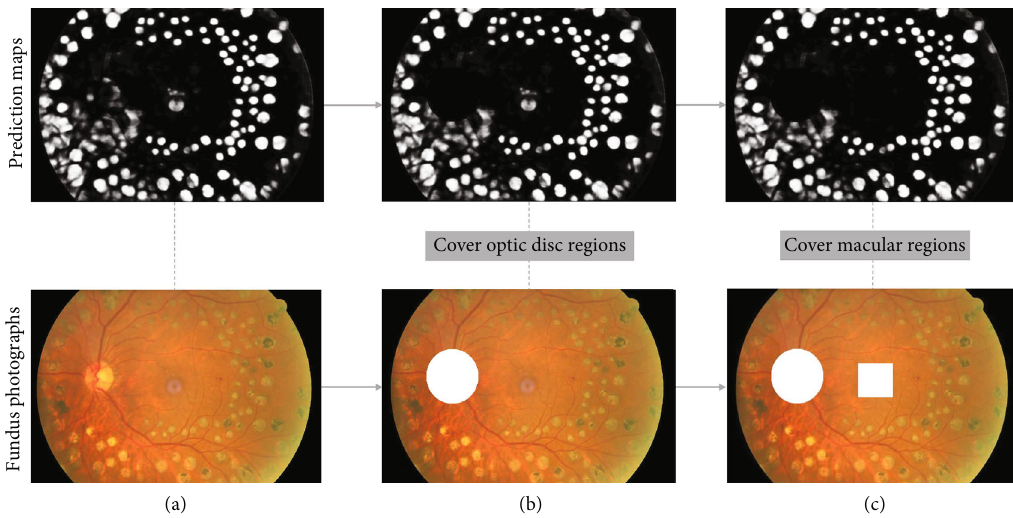
Figure 3: The fl owchart of the postprocessing procedures. The top row presented the prediction maps after each step, and the bottom row showed the corresponding procedures on the fundus photographs. (a) The raw prediction map coming from the lightweight U-Net structure and the corresponding fundus image. (b) The prediction map and the fundus image after an elliptic region around the optic disc were covered. (c) The prediction map and the fundus image after the optic disc and macula region were